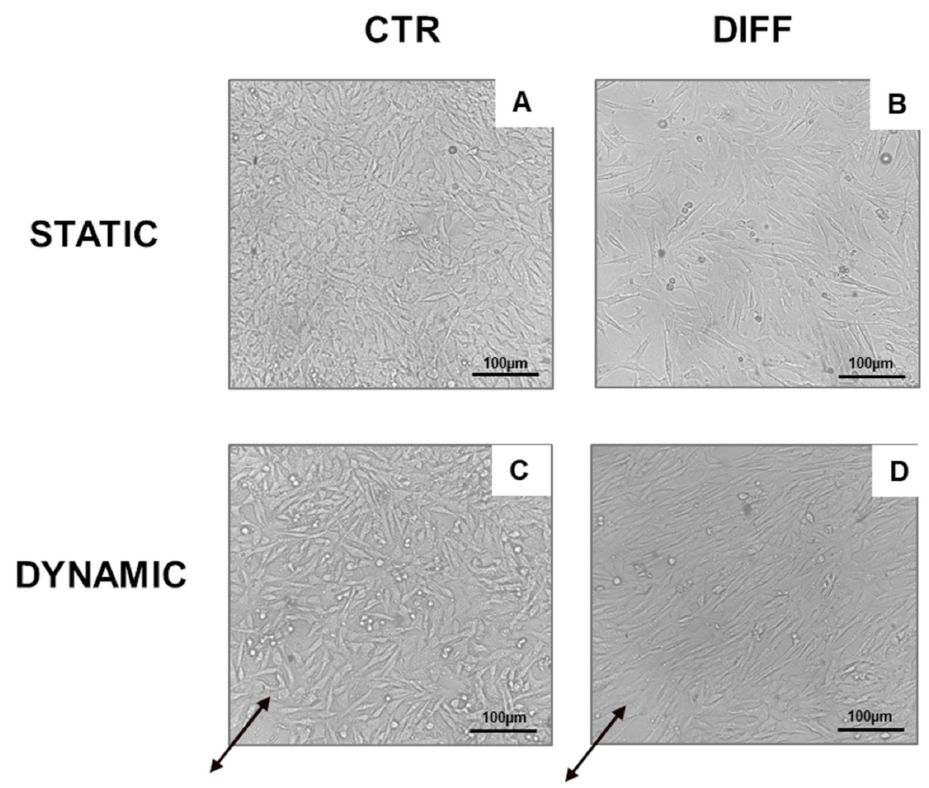
Figure 7. Morphological characteristics of H9c2 cardiomyocytes maintained under static ( A , B ) and dynamic (5% substrate deformation, 1 Hz frequency) conditions ( C , D ) for 7 days. Black arrows indicate the stretching direction. Images are representative of the results obtained in the different experimental conditions. Scale bar: 100 µ m.